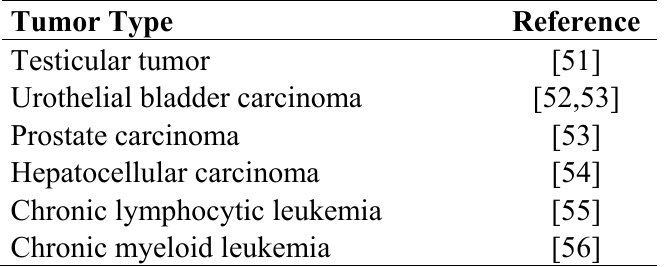
Table 2. Activation of retrotransposons in